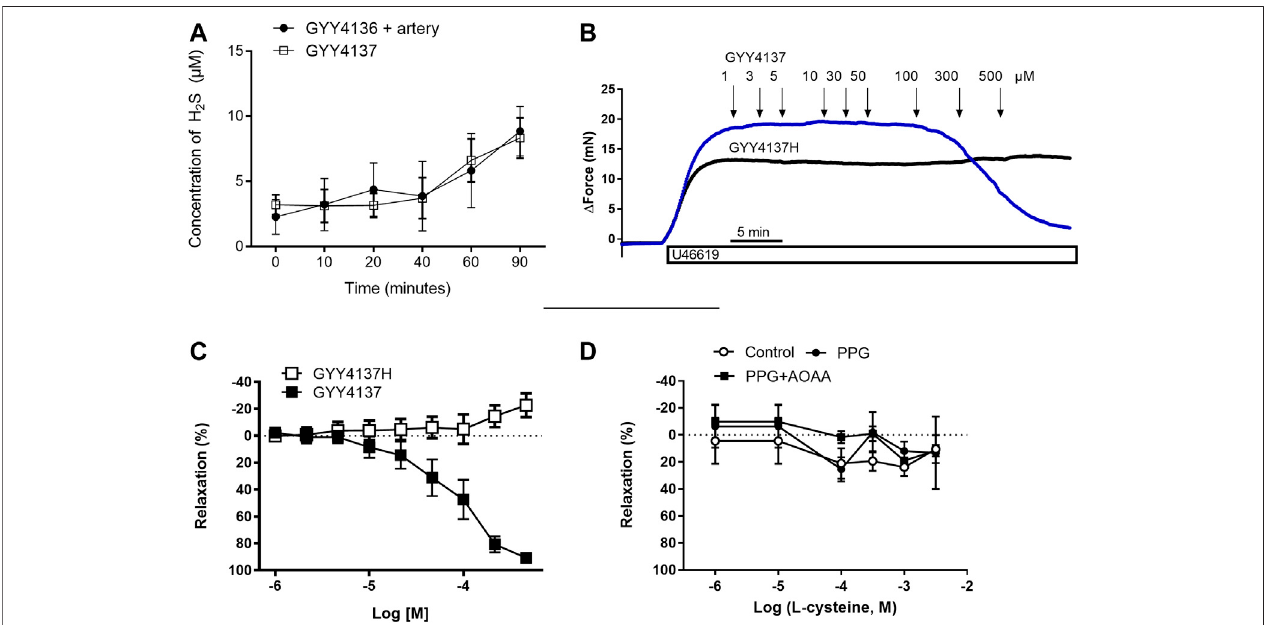
FIGURE1| RoleofH 2 SforGYY4137relaxationssmallmesentericarteries. (A) Sul fi dereleasefromGYY4137intheabsenceandthepresenceofsmallmesenteric arteries (B) Originalrecordingsinsmallmesentericarteriesshowingcontraction to3 µM U46619andaddition ofincreasingconcentrationsofGYY4137 (1 – 500 µM)and the hydrolyzed form of GYY4137H (1 – 500 µM) (C) Average relaxations induced by the parent compound and the hydrolyzed form of GYY4137. (D) Effect of the substrate for H 2 S synthesis, L-cysteine, on vascular tone in small mesenteric arteries. The arteries were incubated with an inhibitors of H 2 S biosynthesis using the cystathionine-gamma-lyase (CSE) inhibitor, PPG (1 mM), and the cystathionine-beta-synthase (CBS)/cystathionine-gamma-lyase (CSE) inhibitor aminooxyacetic